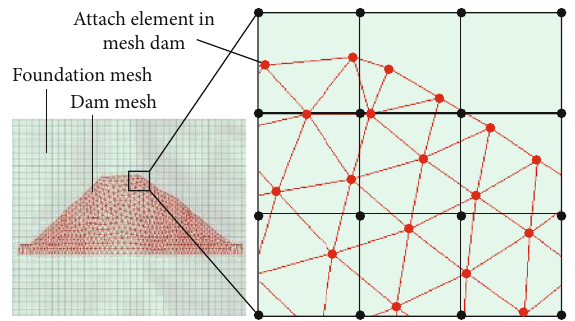
Figure 7: Model mesh settings for foundation base of the